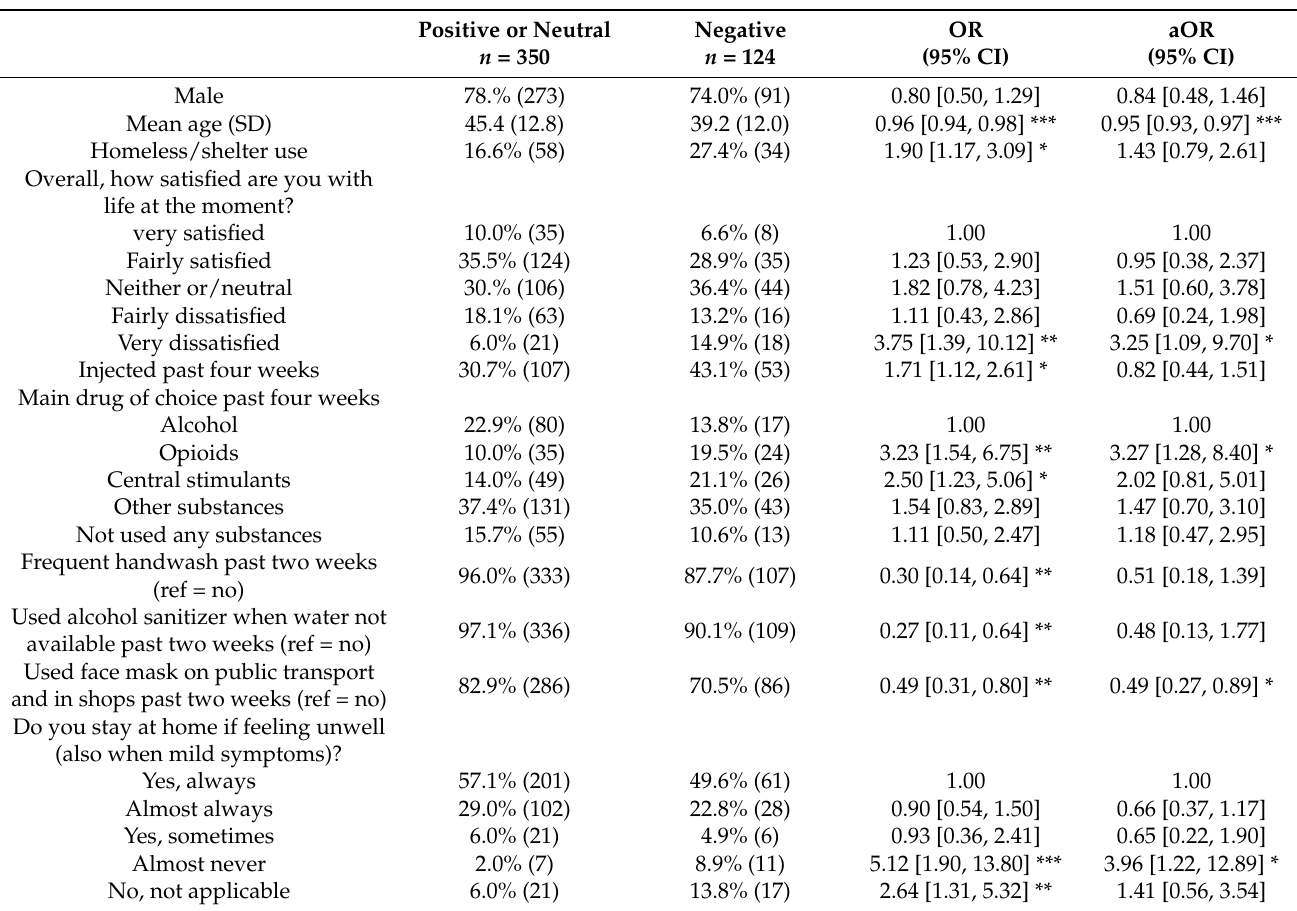
Table 4. Predictors for being negative towards COVID-19 vaccination in a sample of PUD ( n = 452) estimated using univariate and multivariable logistic regression analysis. Being positive or neutral towards COVID-19 vaccination comprise the reference